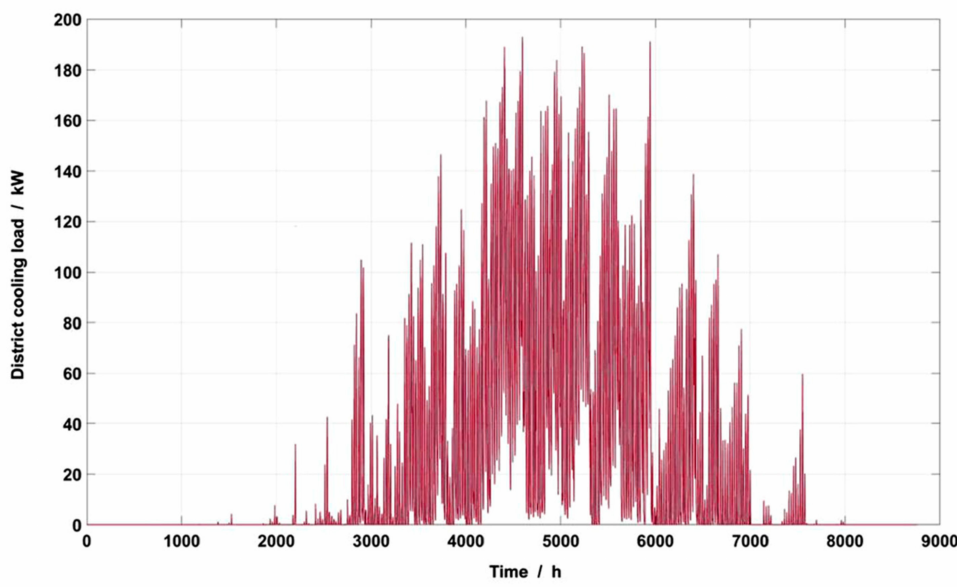
Figure 8. Annual hourly air conditioning cooling load.